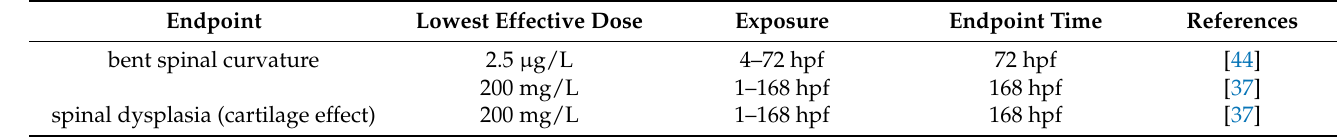
Table 4. Skeletal toxicity from acute exposure to DEHP on zebrafish